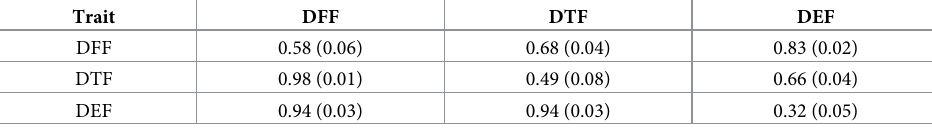
Table 3. Genetic parameters 1 (standard error) 2 for phenological traits 3 in the common bean. Trait DFF DTF DEF DFF